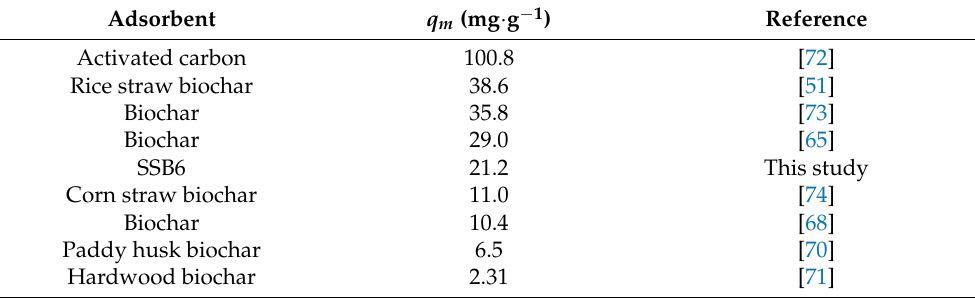
Table 11. The ability of various adsorbents to remove Zn 2+ cations from aqueous solutions.